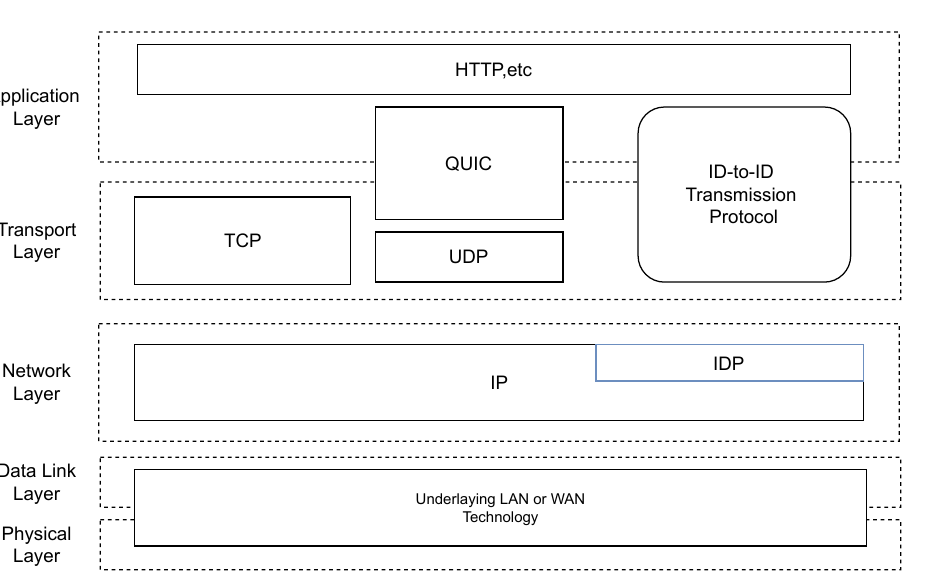
Figure 2. IDP Protocol Layer